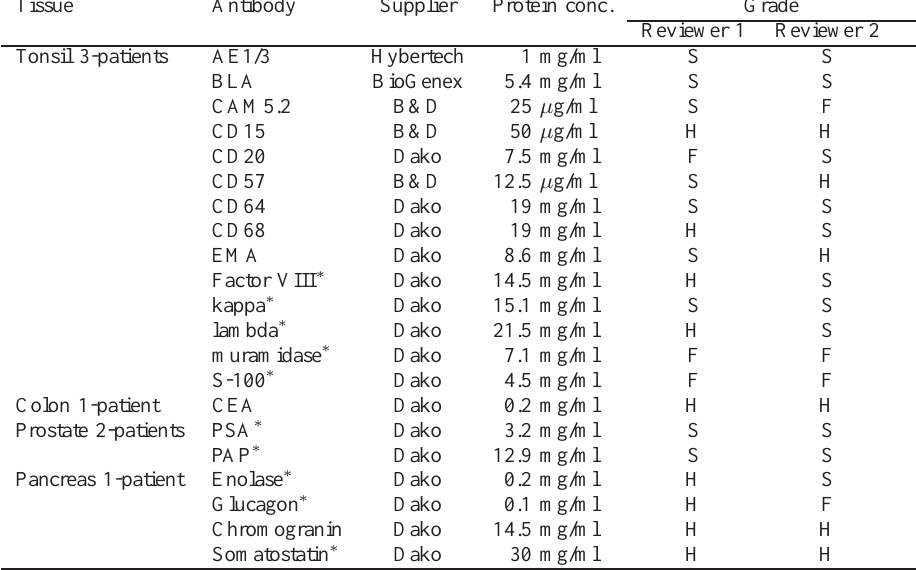
Table 1 Reviewer 1